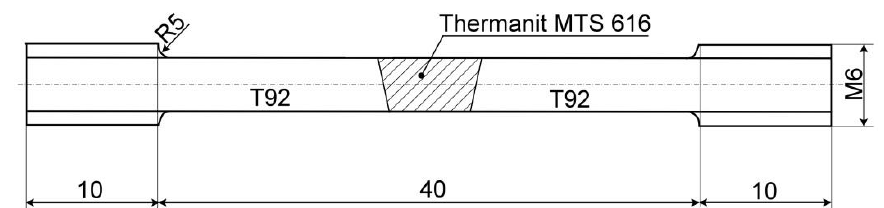
Figure 2. The tensile test specimen for cross-weld tensile testing of T92/T92 weldments (All dimensions are in mm), gauge length diameter 4 mm, gauge length 38 mm.